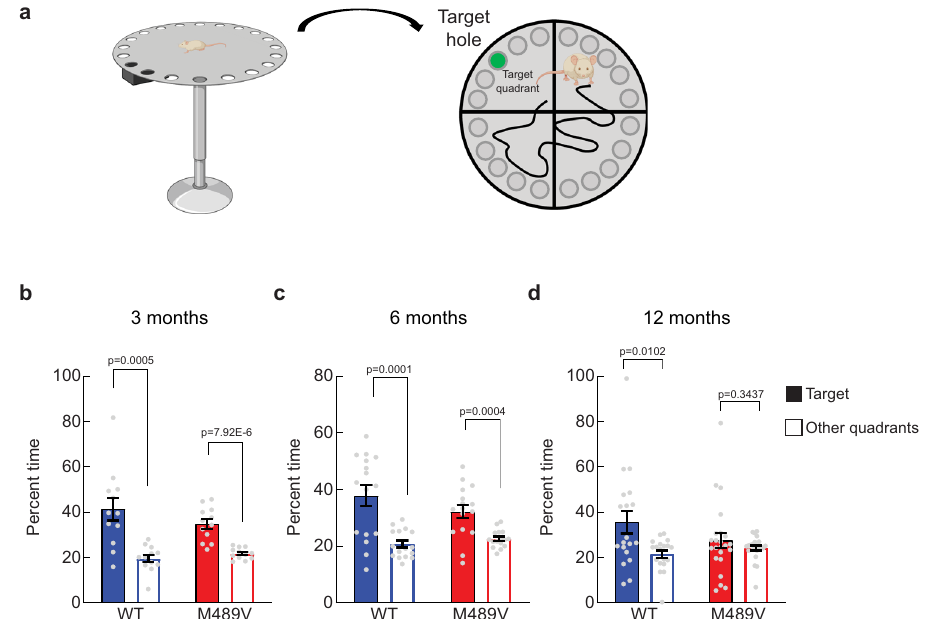
Fig.3|ImpairedspatiallearningandmemoryinC57BL/6PKC α M489V/M489V mice in the Barnes maze test. a Schematic of the Barnes maze test. Created with Biorender.com. b – d Percent time spent in the target quadrant ( fi lled bars) versus theaverageoftheotherquadrants(openbars)intheprobetestinseparategroups of 3 ( b ), 6 ( c ), and 12 ( d ) months old mice. Group sizes: 3-month (WT: 4 males, 8 females, M489V littermates: 6 males, 6 females),6-month (WT:8 males, 8 females,